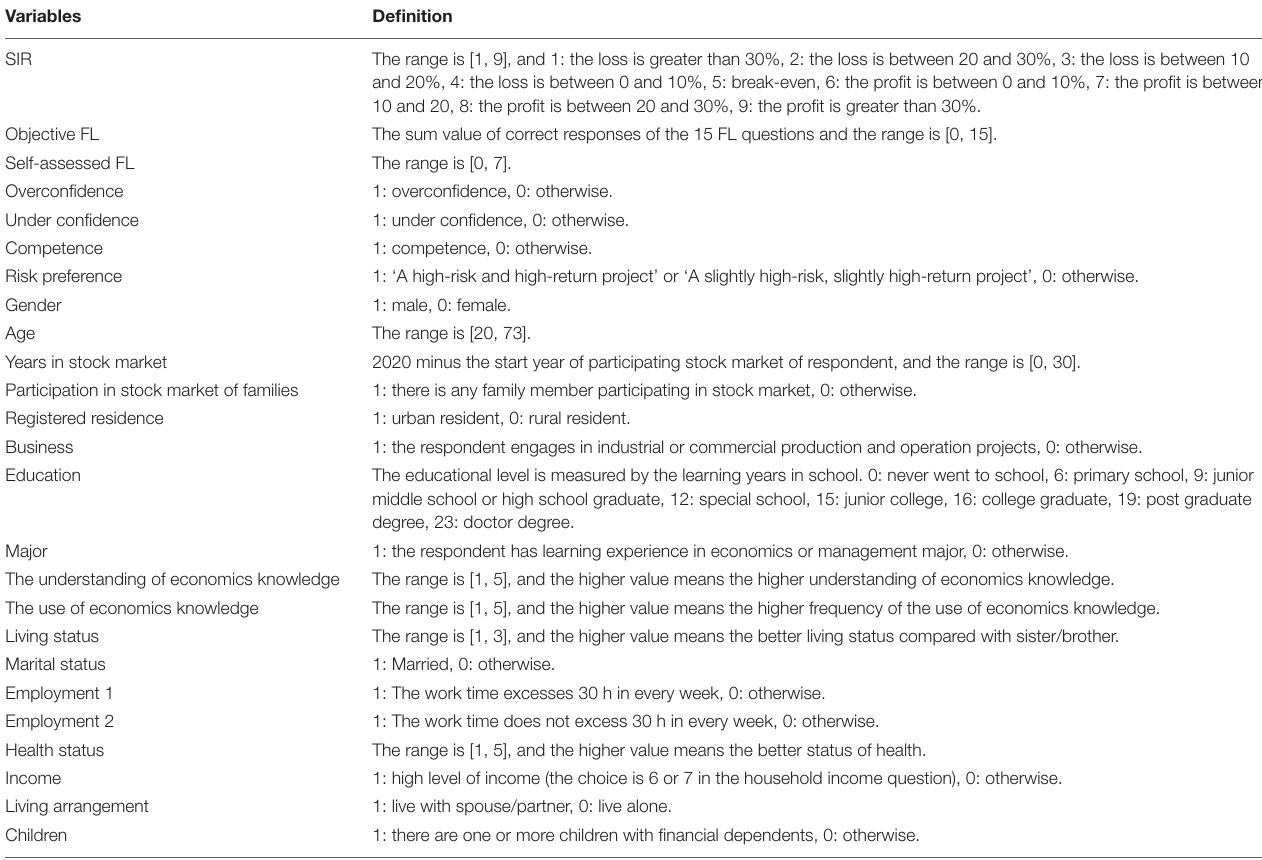
TABLE 4 | The definition of